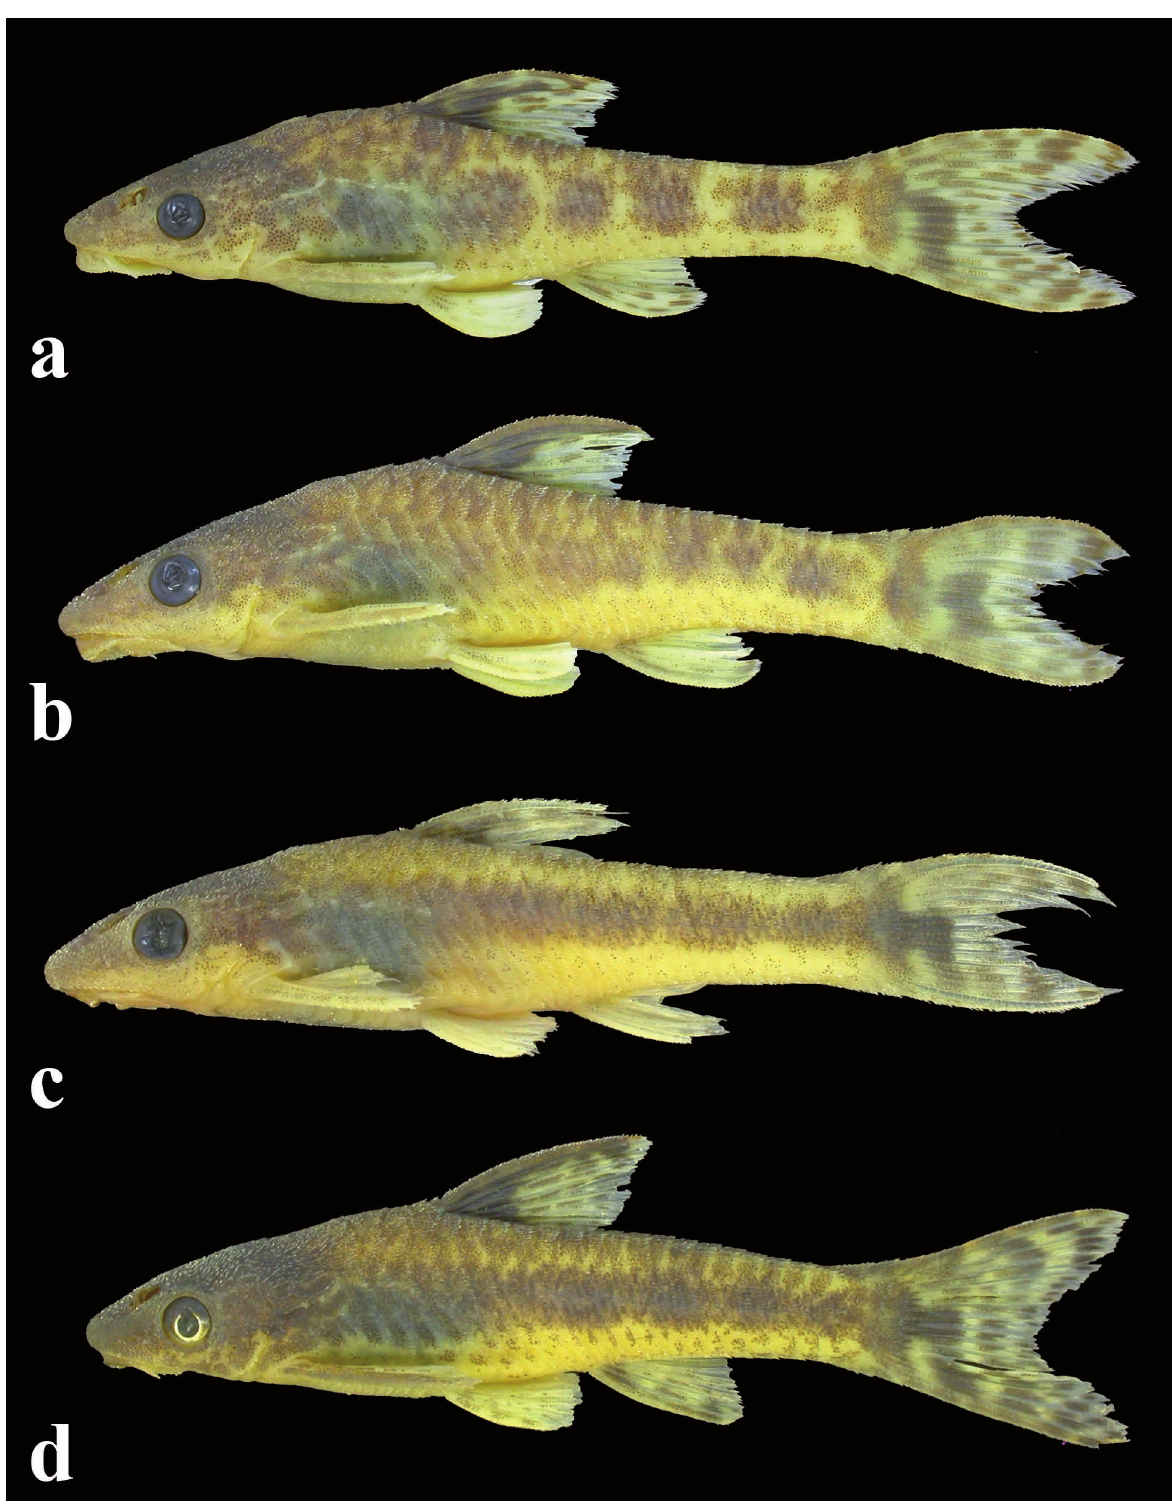
Fig. 3. Color variation of Otocinclus arnoldi . (a) and (b) : MCP 25234, SL = 43.8 and 39.0 mm; (c) : MCP 32565, SL = 31.9 mm; and (d) : UFRGS 6838, SL = 30.4